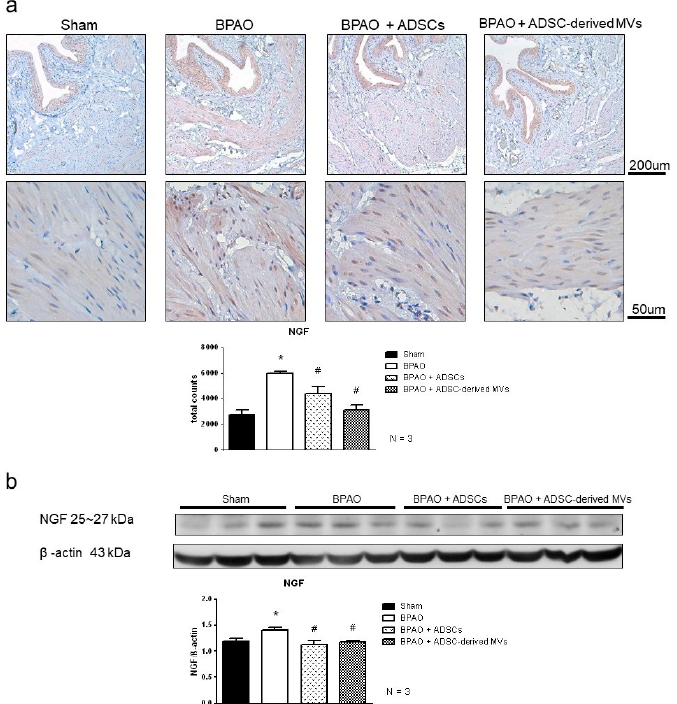
Figure 9. NGF staining and expression in separated group. In the top panel, ( a ) showed the NGF staining and image analysis of NGF staining. It showed significantly increased NGF density in BPAO group compared to sham group. The NGF density in BPAO + ADSCs and BPAO + ADSC-derived MVs group were significantly decreased compared to BPAO group ( # p < 0.05). In the bottom panel, ( b ) showed the western blot of NGF level. It showed significantly increased level of NGF expression in BPAO group compared to the other groups (* p < 0.05). The NGF level is lower in BPAO + ADSCs group and BPAO + ADSC-derived MVs group compared to BPAO group ( # p < 0.05).